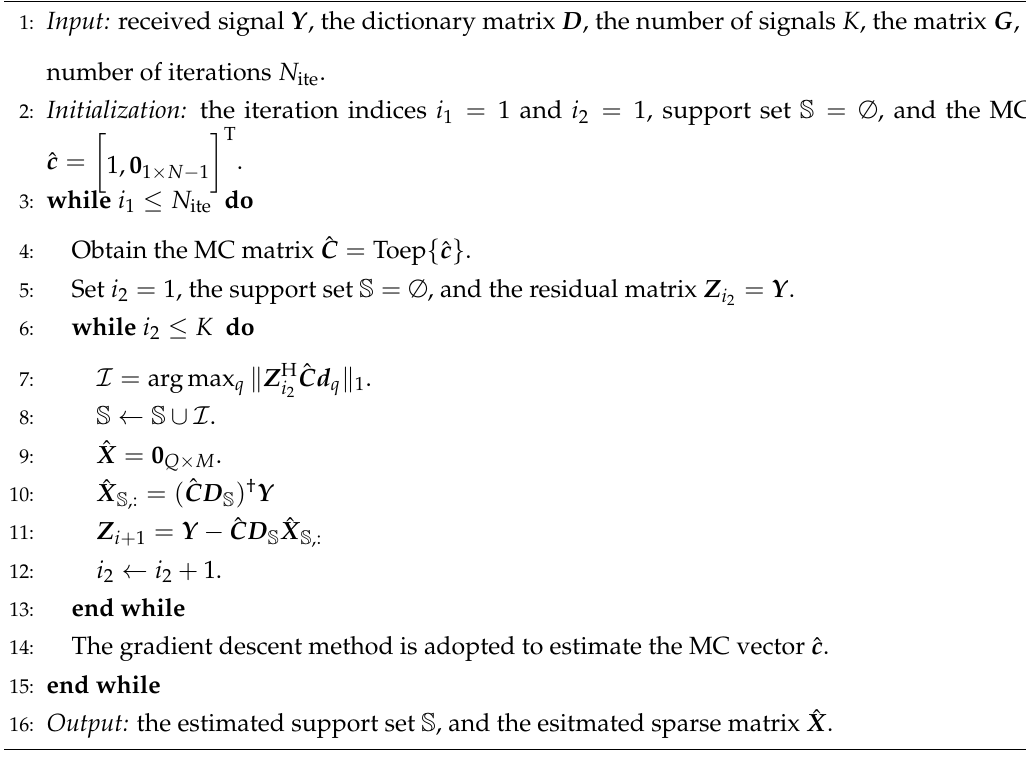
Algorithm 1 DOA estimation with unknown MC effect (SDMC algorithm).